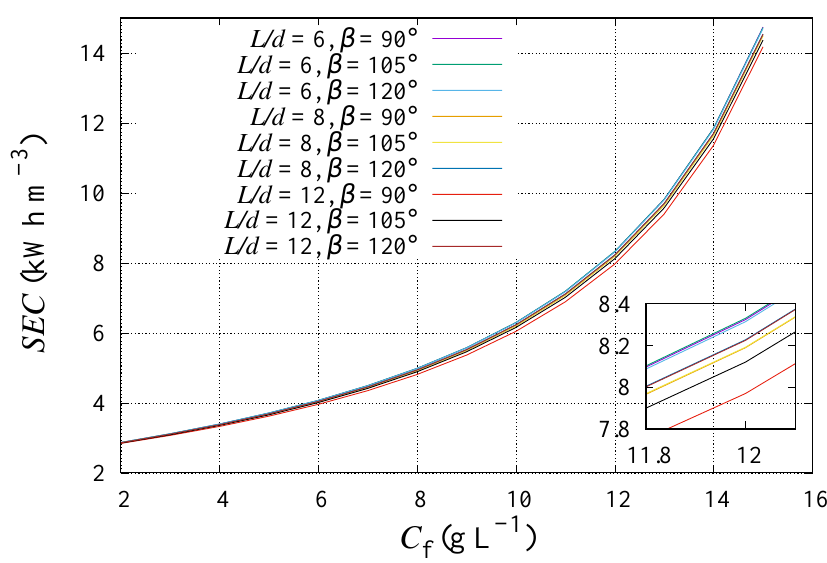
Figure 3. SEC of the membrane FILMTEC TM BW30-400 considering different feed spacer geometries, a range of C f , p f = 15 bar and Q f = 11 m 3 h − 1 .